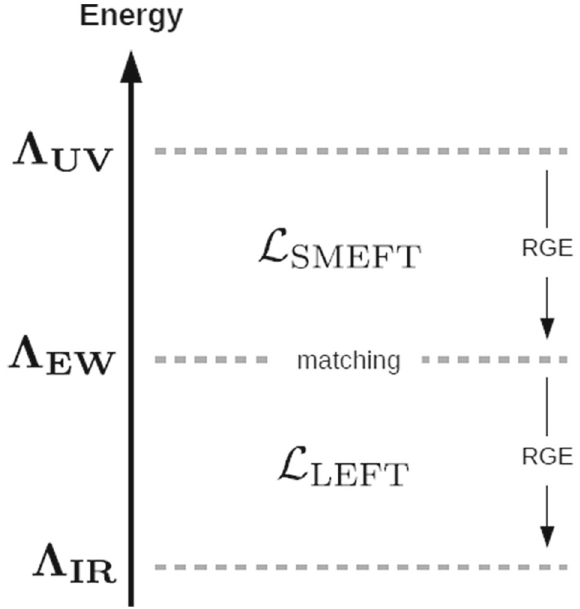
Fig. 1 Scketch of the DsixTools matching-running routine. The DsixTools terminology is: (cid:2) UV = HIGHSCALE , (cid:2) EW = EWSCALE and (cid:2) IR = LOWSCALE . The default is EWSCALE = M Z = 91 . 1876